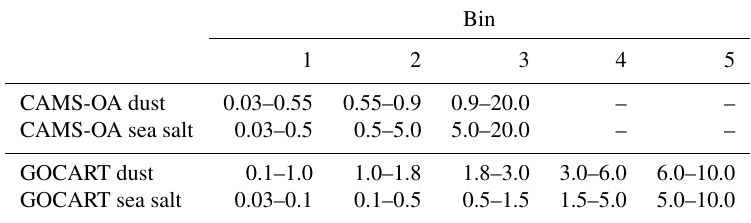
Table 2. Radii ranges (µm) of dust and sea salt bins used in the GOCART model (WRF-Chem, MERRA-2) and in CAMS-OA.